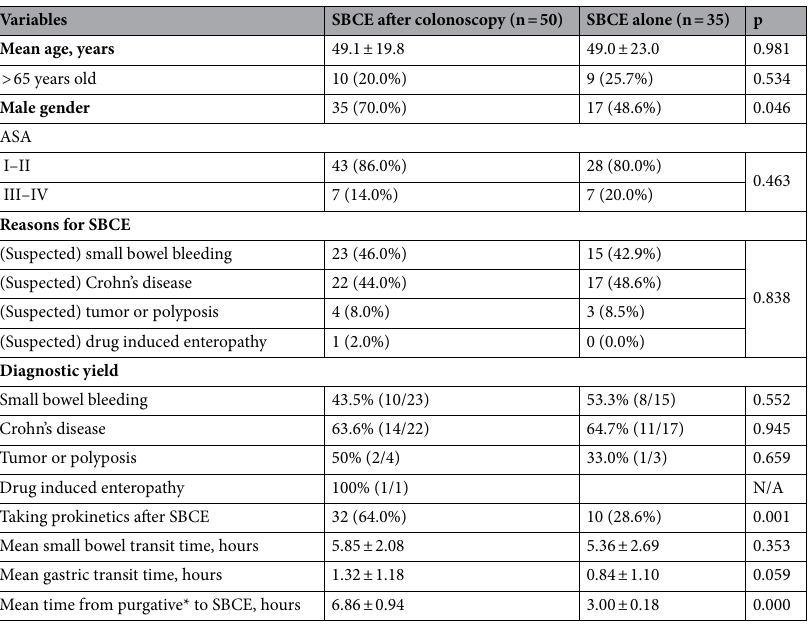
Table 1. Baseline characteristics of patients who underwent small bowel capsule endoscopy (SBCE) (N = 85). ASA American Society of Anesthesiologists, SD standard deviation. *Last dose of